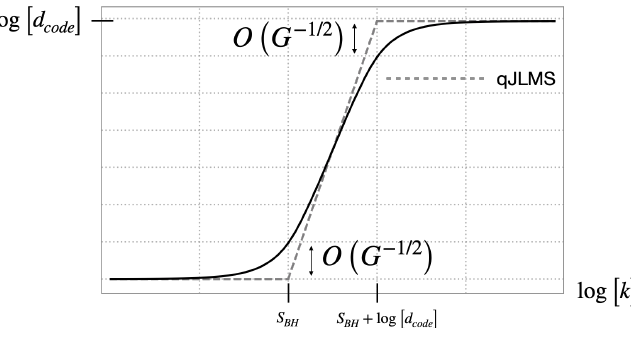
Figure 4 . A sketch of the relative entropy (black line) for the canonical ensemble with σ code being the maximally mixed state in the code subspace. There are two locations with O (cid:0) G − 1 / 2 (cid:1)